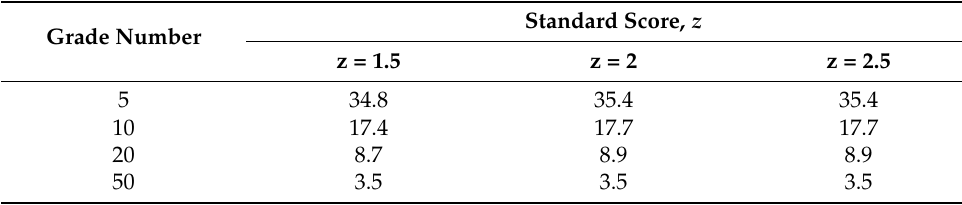
Table 4. Bandwidth versus various numbers of grades and z-scores (unit: µ m).